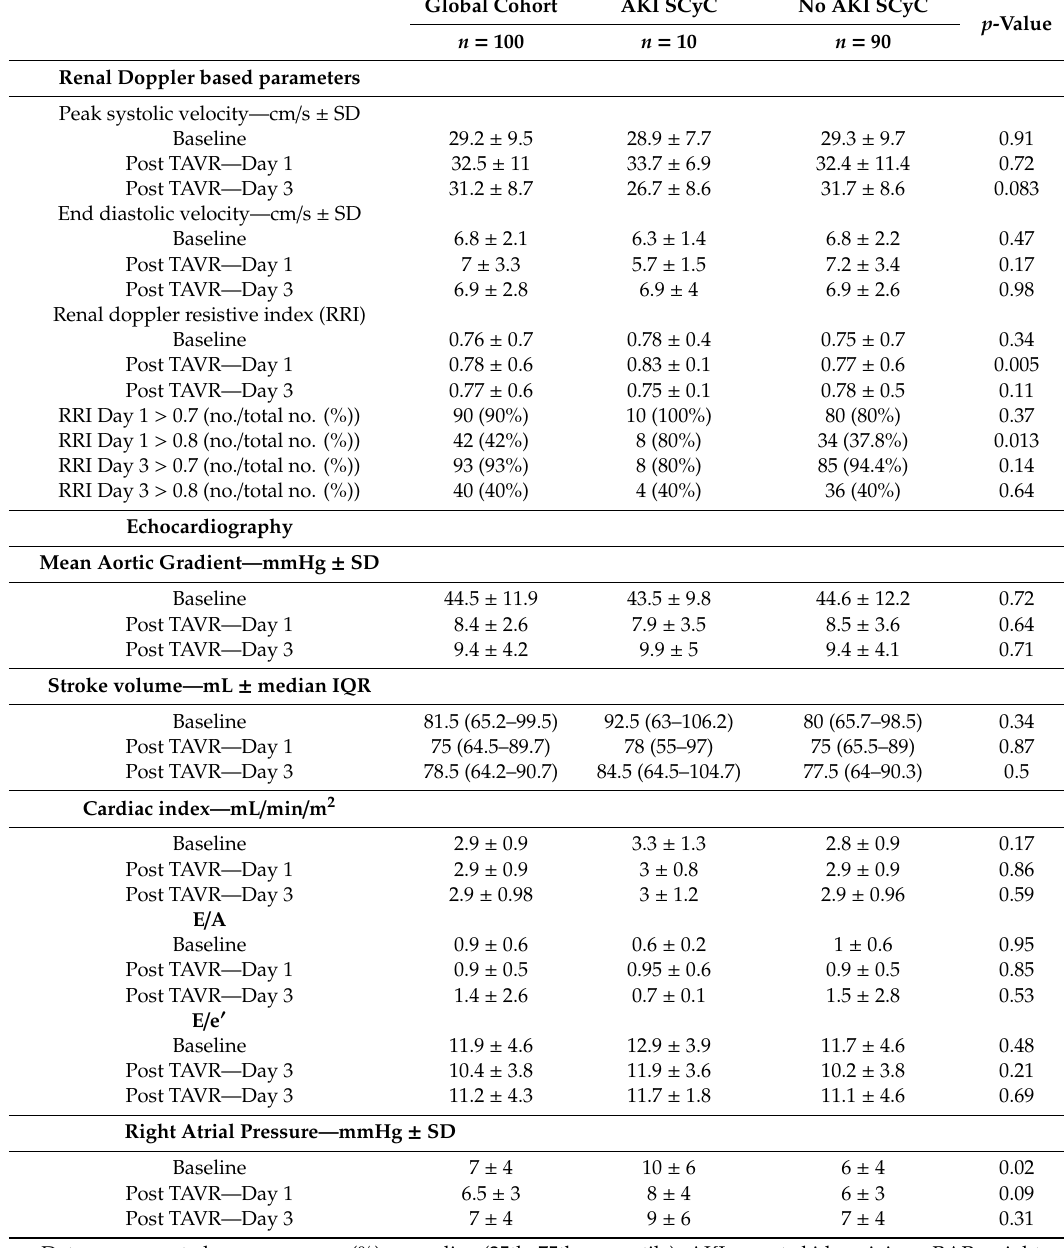
Table 5. Doppler based resistive index and hemodynamic